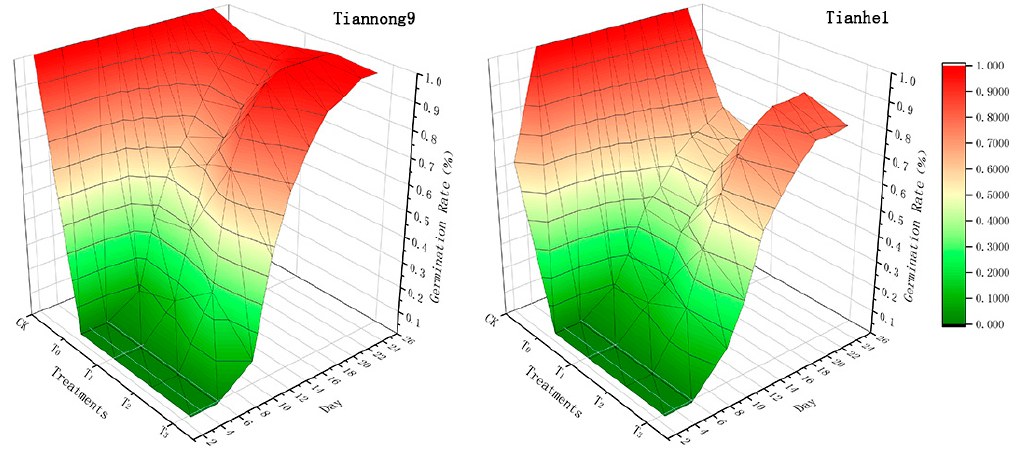
Figure 1. The effects of soaking in different concentrations of BL on the maize seed germination